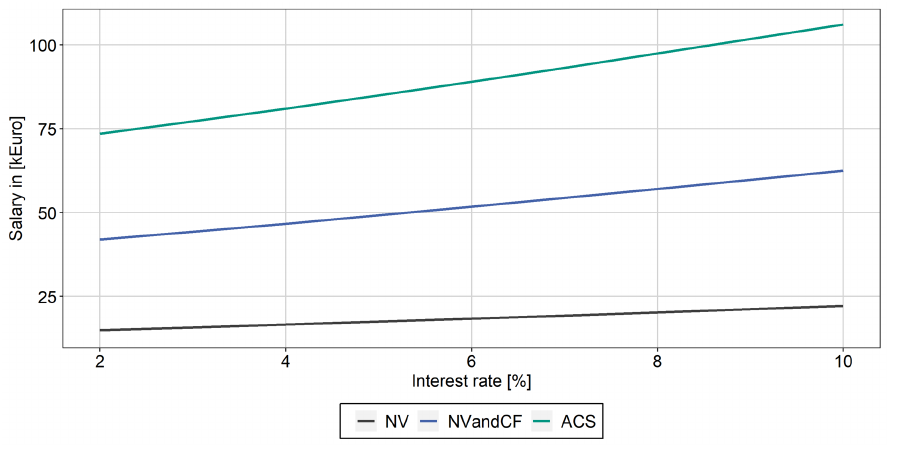
Figure 5. Interest rate and salary for ∆ NPV = 0.